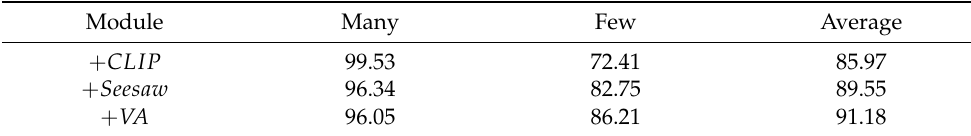
Table 9. Ablation of the different